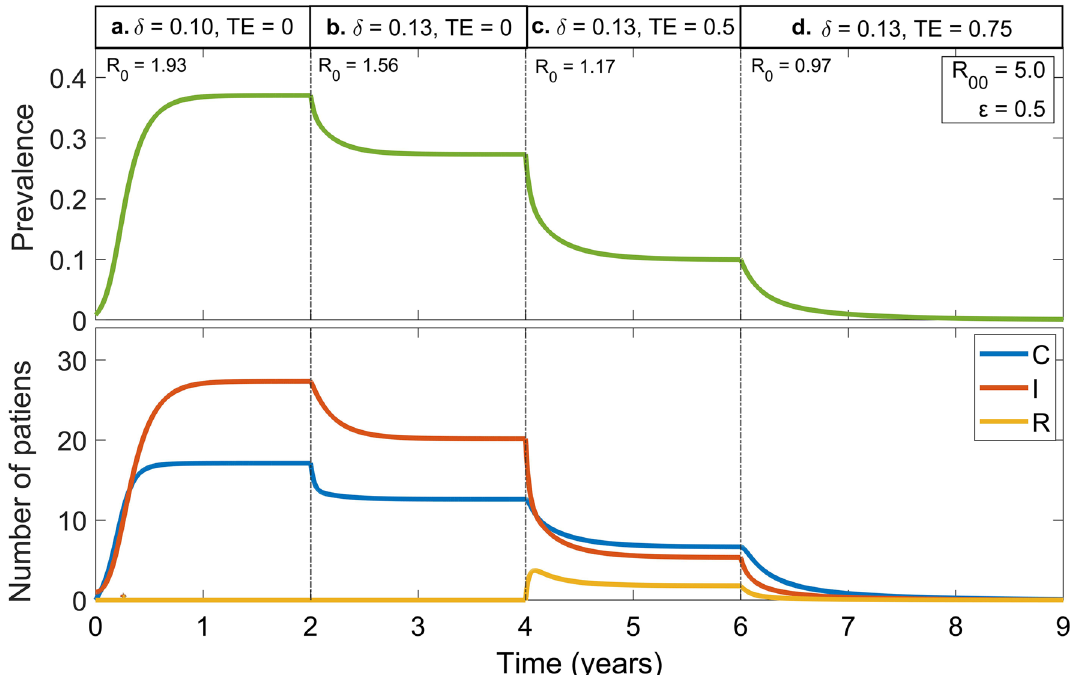
Figure 6. Impact of successive interventions on the time course of infection progression. The epidemic with no intervention (Panel a ) is controlled by increasing precaution compliance (Panel b ), followed by using the treatment on symptomatic colonized patients (Panel c ), and finally by enhancing the treatment efficacy (Panel d ). The impact of successive interventions on the epidemic time course is represented by the prevalence (above) and number of patients